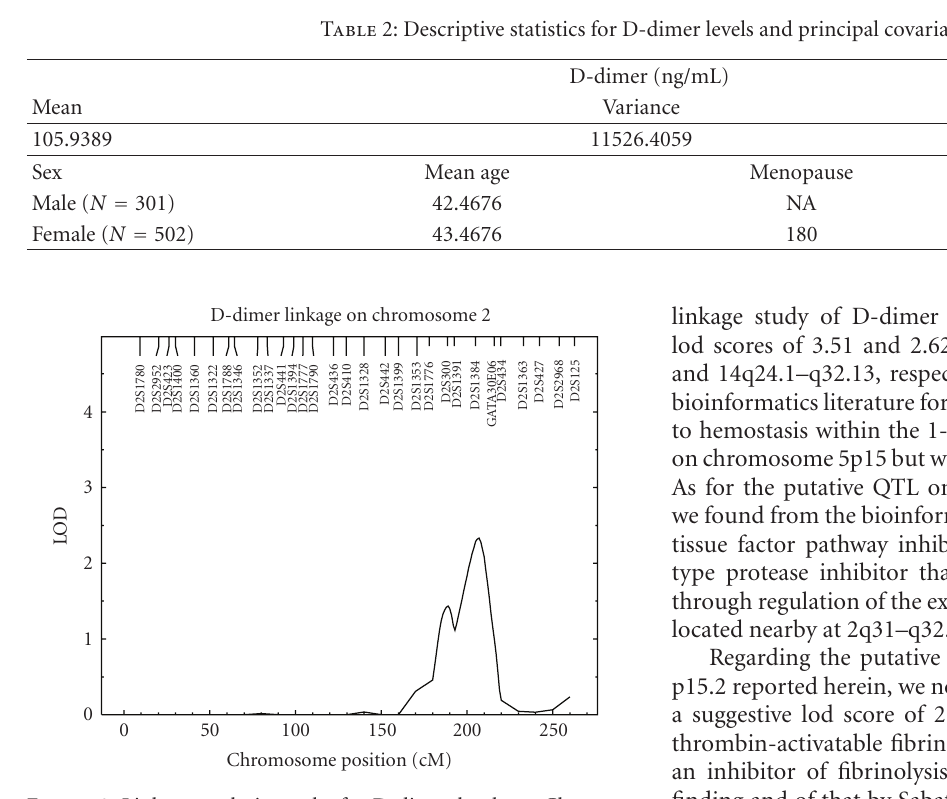
Figure 3: Linkage analysis results for D-dimer levels on Chromo- some 2. Axes are as in Figure